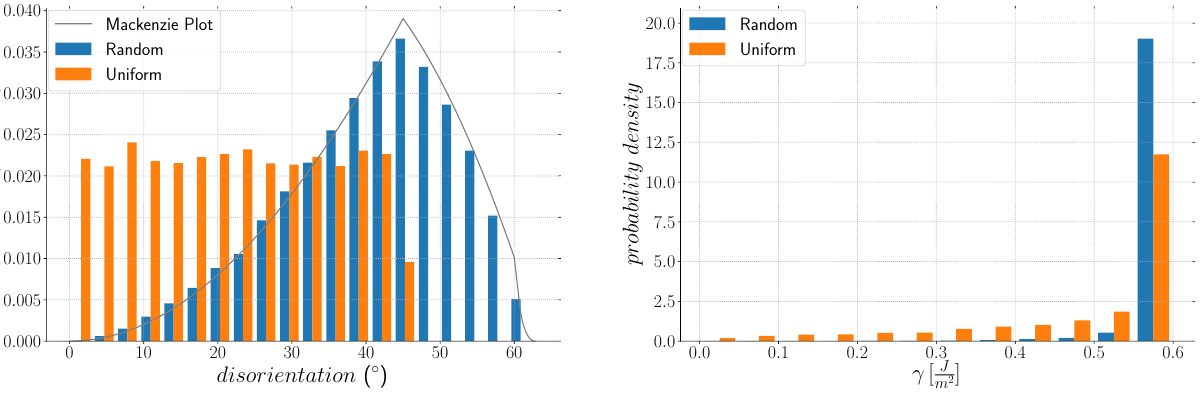
Figure A6. Comparison of GB distribution properties, ( a ) DDf and ( b )